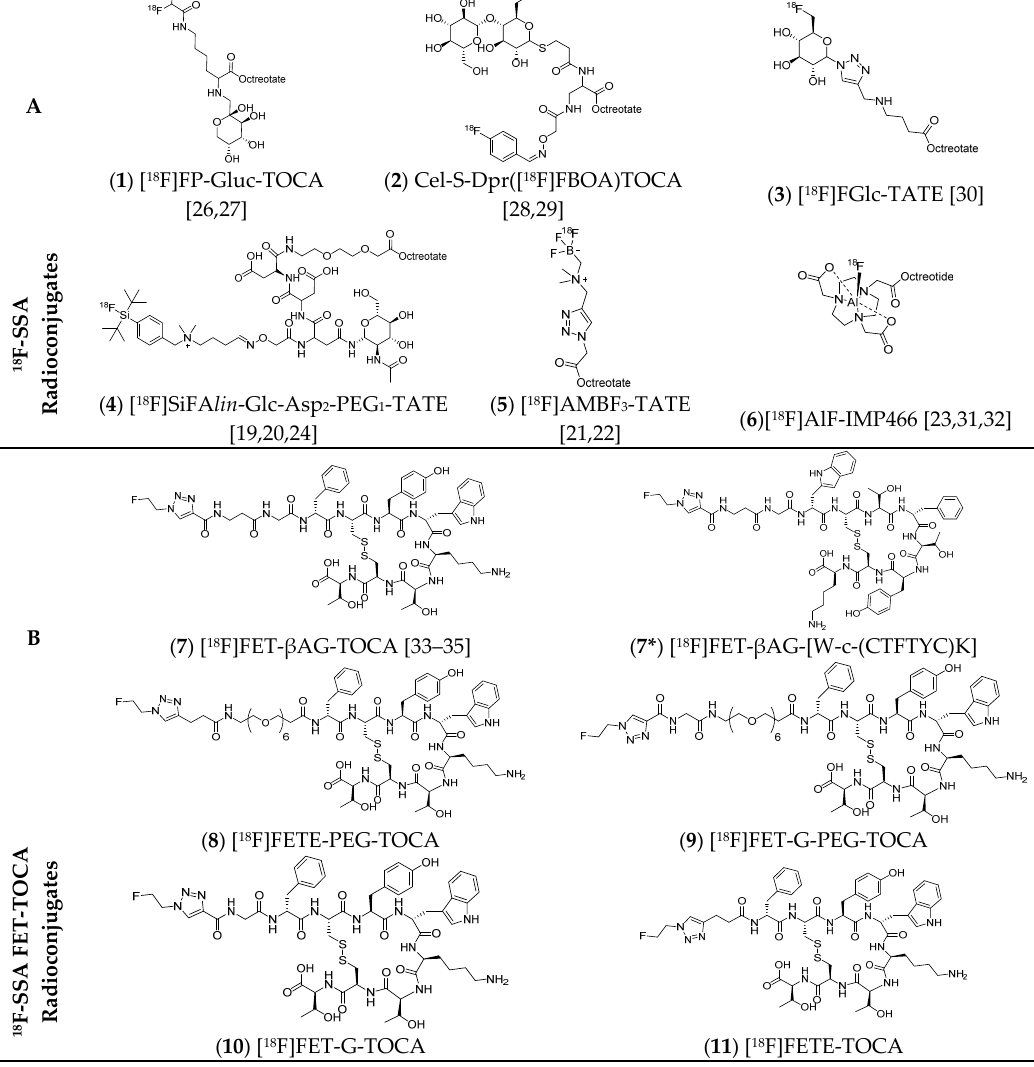
Figure 2. Fluorine-18 radiolabelled somatostatin analogues: ( A ) examples of a variety of 18 F-SSA radioconjugates; ( B ) a focused 18 F-SSA library based on FET-TOCA. Compound 7* is a scrambled derivative of 7 and was used as a negative control.